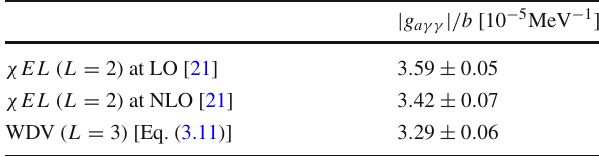
Table 1 Numerical values of the axion-photon-photon coupling con- stant g a γγ , obtained using Eq. (3.11), compared with the predictions of the Chiral Effective Lagrangian ( L = 2) at LO and